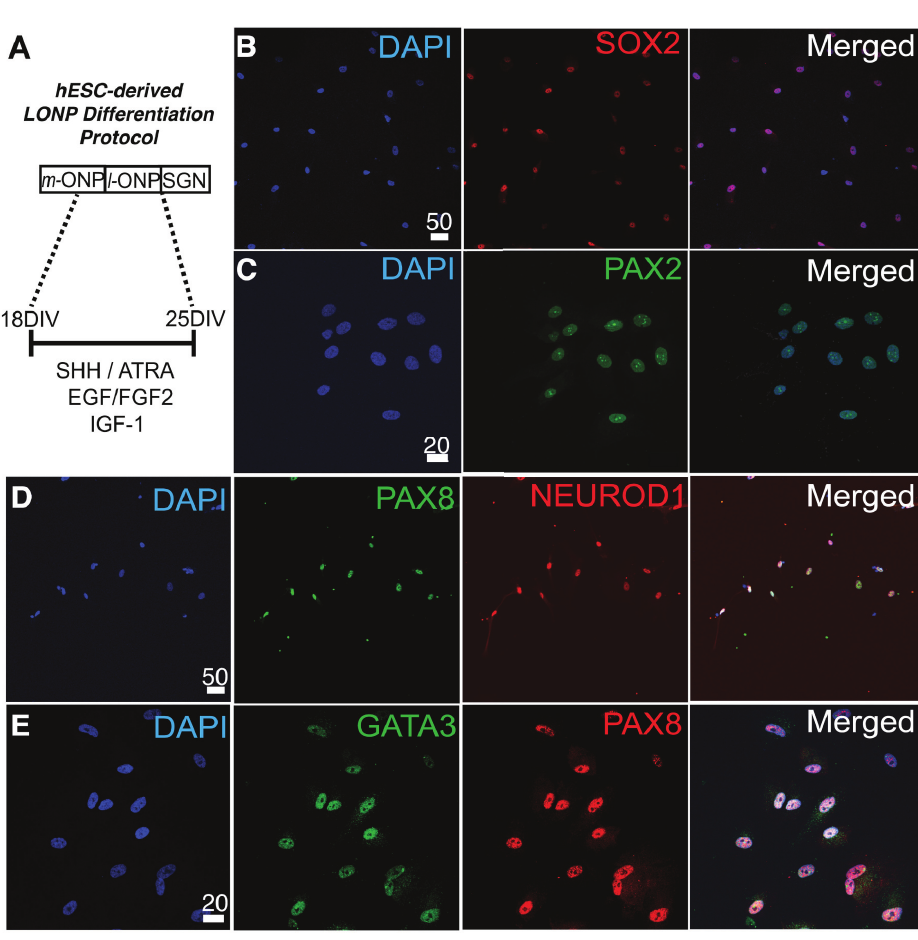
Fig 2. Immunocytochemical assessment of differentiation of mid-stage hESC-derived ONPs into late- stage ONPs. (A) : An experimental paradigm. Immunocytochemistry of late-stage ONPs derived from H1, H7, and H9 undifferentiated ESCs for SOX2 (B) , PAX2 (C) , PAX8/NEUROD1 (D) , and GATA3/PAX8 (E) . Human hESC cell lines used were H7 (C), H9 (B), and H1 (D, E). Scale bars: 50 μ m (B and D) and 20 μ m (C and E). m-ONP: mid-stageONPs; l-ONP: late-stage ONPs; SGN: spiral ganglionneurons; S/R/E/F/I: SHH/ATRA/ EGF/FGF2/IGF-1.